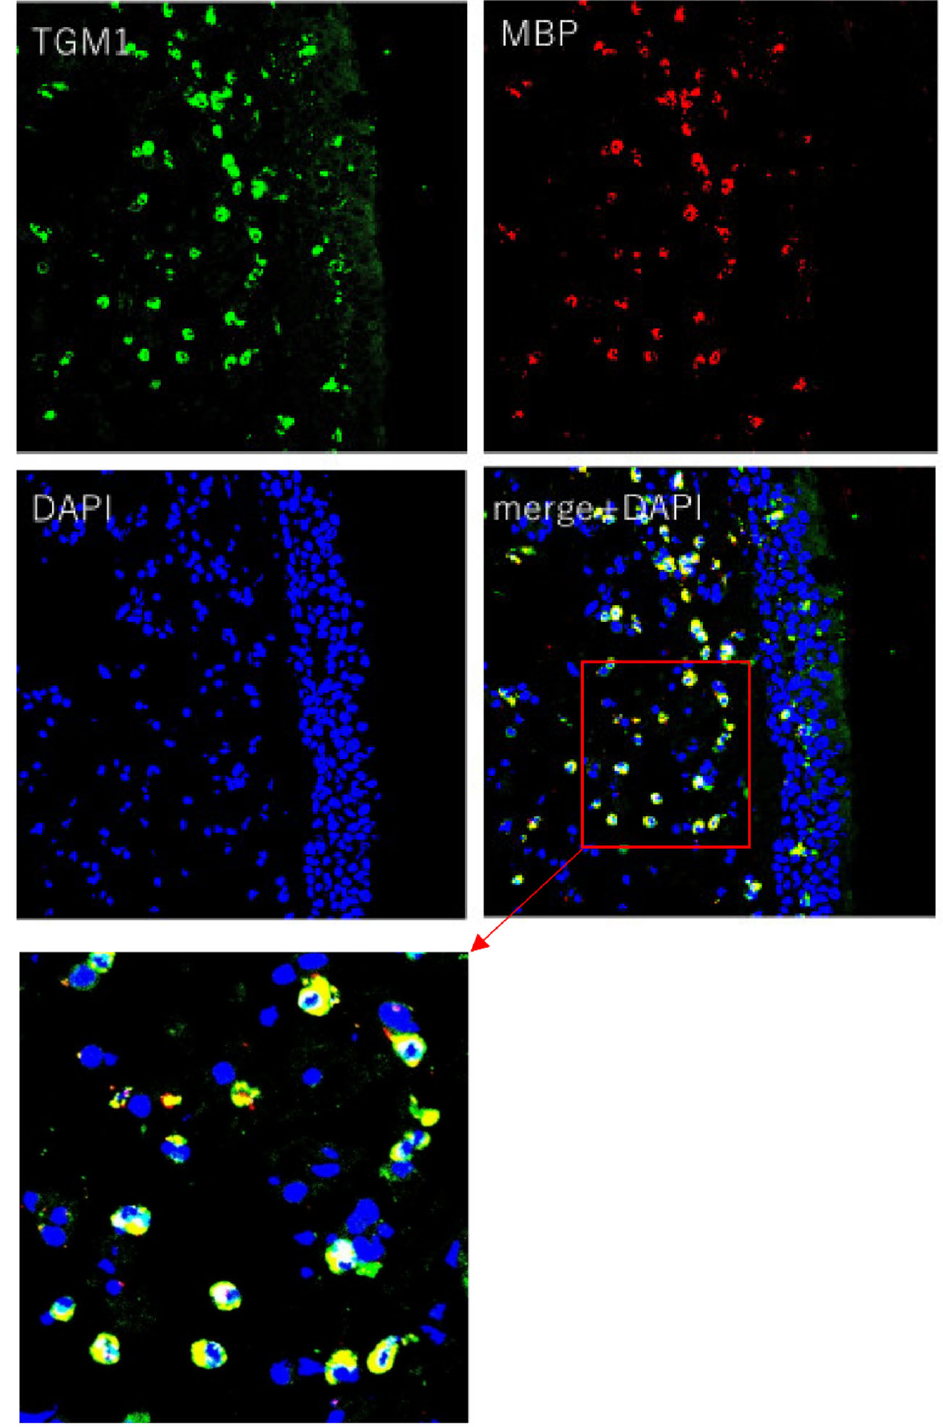
Figure 4. LSCM images of NP (original magnification × 200). LSCM images showed that TGM 1 production was colocalized with MBP (Eosinophil Major Basic protein) positive cell as eosinophils and the location of TGM 1 was mainly in the cytoplasmic region of eosinophil. Immunofluorescence assay was performed with anti-TGM 1 (green fluorescence) and eosinophil (red fluorescence). Nuclei were counterstained with 4 ′ ,6 ‐ diamidino ‐ 2 ‐ phenylindole (DAPI; blue fluorescence).